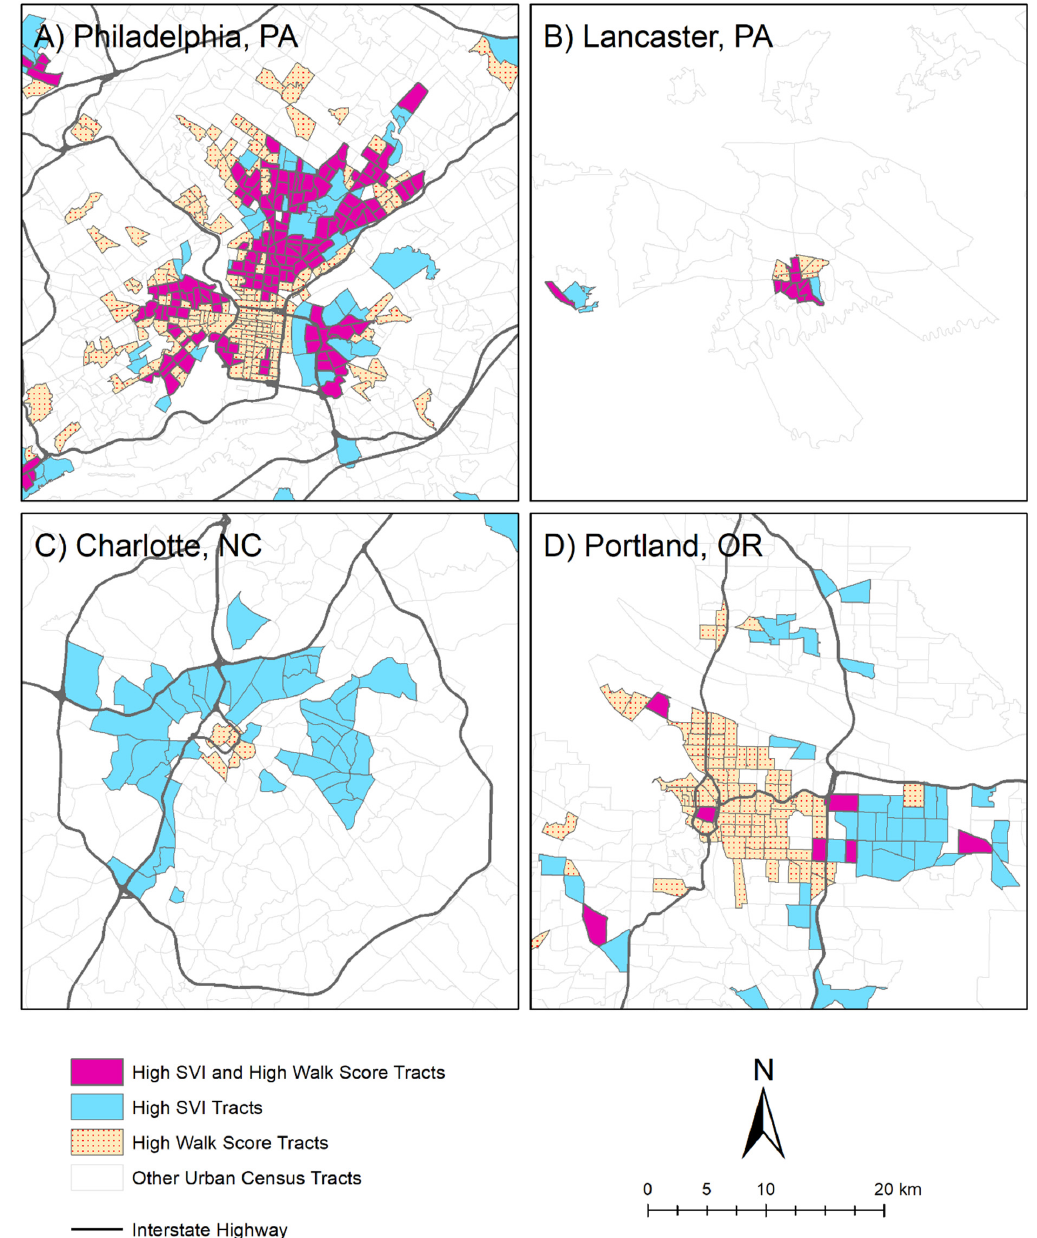
Figure 4. Spatial distribution and overlap of high-SV and highly walkable (walk score ≥ 70) census tracts in ( A ) Philadelphia, PA, ( B ) Lancaster, PA, ( C ) Charlotte, NC, and ( D ) Portland, OR. The average proportion of residents by MSA living in high-SV tracts also living in high-transit tracts was 10.8%; nearly twice the average proportion of all residents living in high-transit tracts (Appendix B, Figure 5). New York, Philadelphia, and Boston again had the highest proportions of residents living in high-SV/high-transit census tracts at 87, 82, and 69%, respectively. These metros have extensive rail systems that include subway lines and dense, historical urban centers that support walking and frequent transit service.